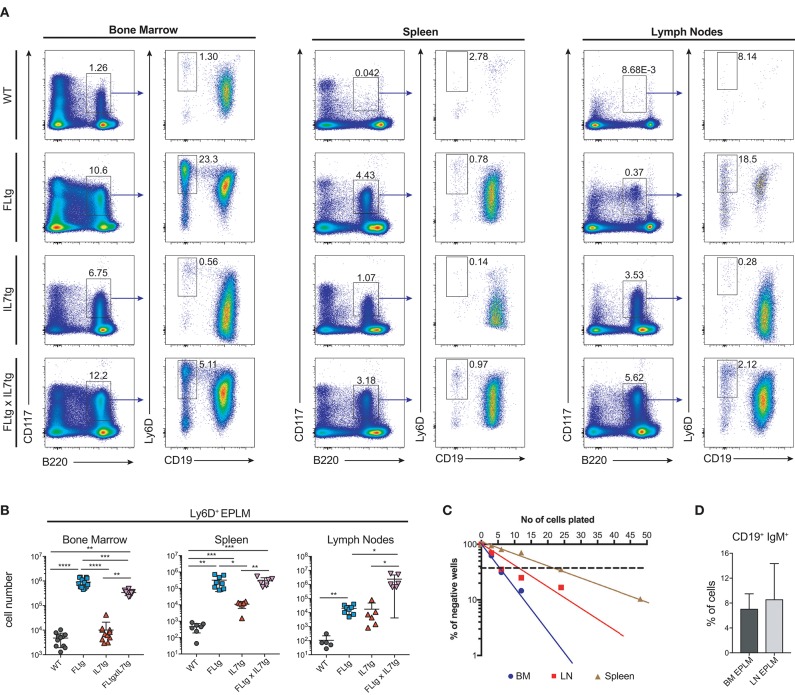
Ly6D+ EPLM accumulate in the spleen and lymph nodes of FLtgxIL7tg mice. (A) Representative FACS plots for the identification of Ly6D+ EPLM in the bone marrow (femurs and tibias) (Left), spleen (Middle) and lymph nodes (axillary and inguinal) (Right) of WT, FLtg, IL7tg, and FLtgxIL7tg mice. Gate numbers indicate frequencies of parent gate. In every panel the initial plot (CD117 vs. B220) shows live, SiglecH−CD11c−NK1.1− cells. (B) Numbers of Ly6D+ EPLM (NK1.1−CD11c−SiglecH−CD19−B220intCD117intLy6D+) in the bone marrow, spleen and lymph nodes of WT, FLtg, IL7tg and FLtgxIL7tg mice. (C)
In vitro differentiation potential of Ly6D+ EPLM from bone marrow (blue), spleen (red) and lymph nodes (brown) of FLtgxIL7tg mice. Cells were plated on OP9 stromal cells + IL-7 at different cell densities and the number of wells containing B cells were scored under the microscope after 10 days. One representative of three independent experiments is shown. (D)
In vivo B cell reconstitution potential of Ly6D+ EPLM from bone marrow (black) or lymph nodes (gray) of FLtgxIL7tg mice. Six thousand Ly6D+ EPLM were intravenously injected into NOD/SCID/Il2rγ−/− mice (n = 5) and the percentage of CD19+IgM+ donor cells was evaluated in the spleen of recipient animals 3 weeks after transplantation. *p < 0.05, **p < 0.01, ****p < 0.0001. Error bars indicate standard deviation.